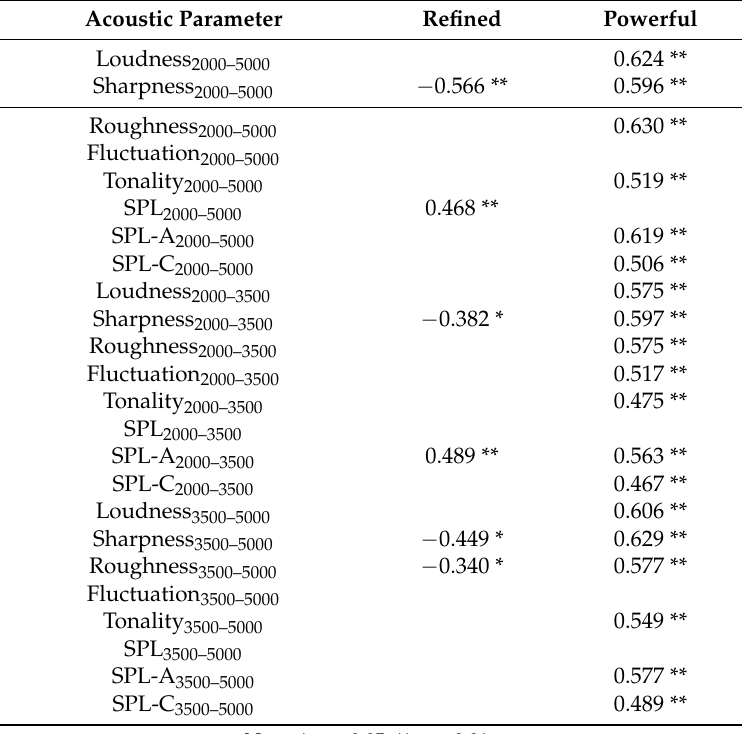
Table 7. Results of correlation analysis between affective dimension and acoustic parameter.